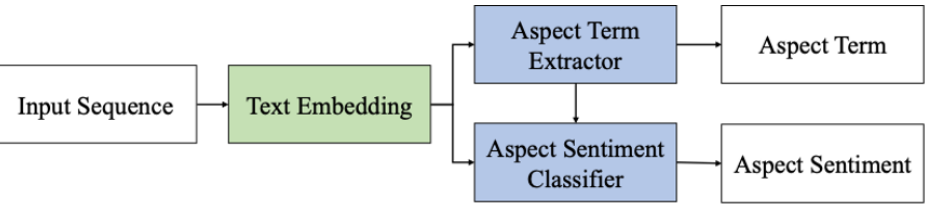
Figure 1. ABSA task